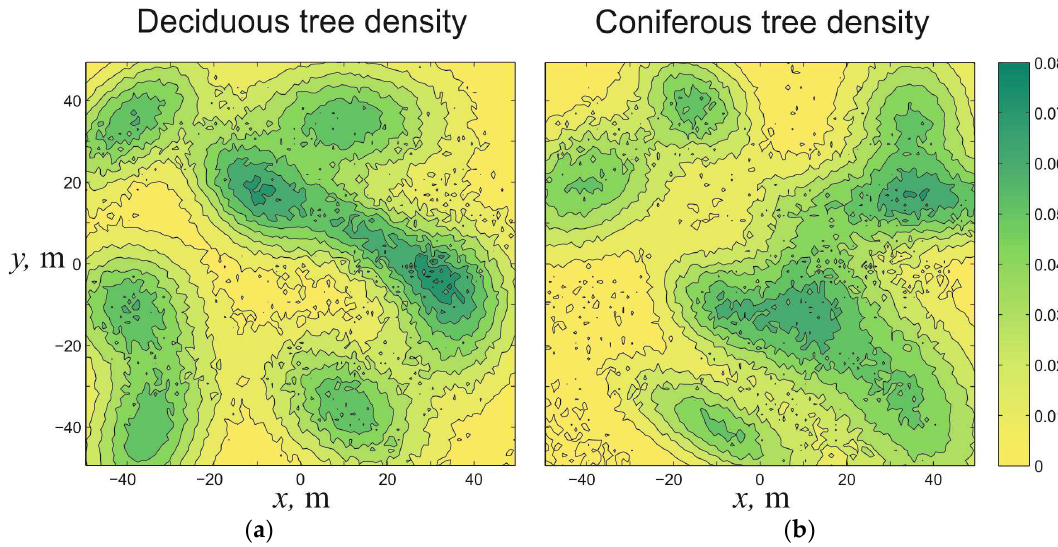
Figure 8. The result of the functions ρ 1 ( x , y ) ( a ) and ρ 2 ( x , y ) ( b ) retrieving on the N x × N y ≡ 100 × 80 grids for a set of measurements of N p = 10 points with simulated errors h = 1%, δ =